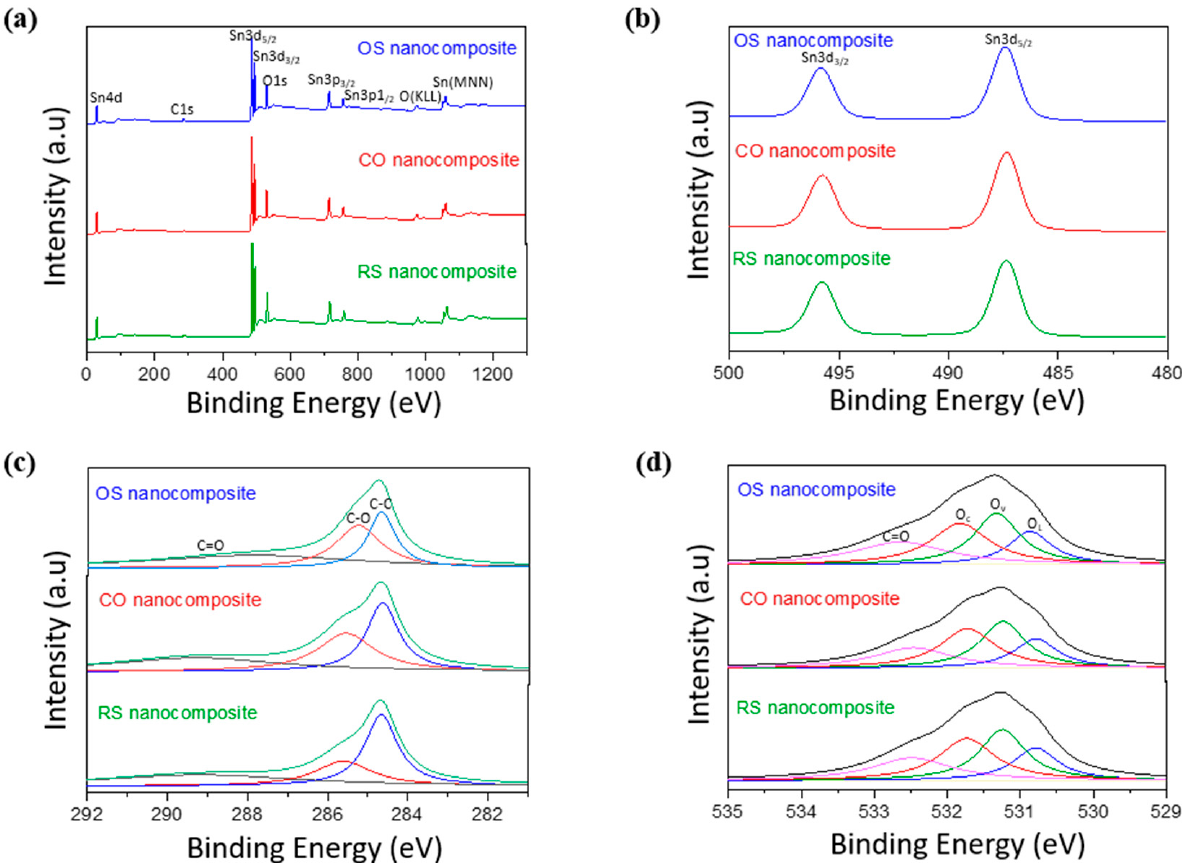
Figure 6. The ( a ) XPS spectra, ( b ) Sn3d XPS spectra, ( c ) C1s XPS spectra, and ( d ) O1s XPS spectra of OS, CO, and RS nanocomposites. Table 1. The fitting results of the content and content ratio of each atom for OS, CO, and RS nano- composites.